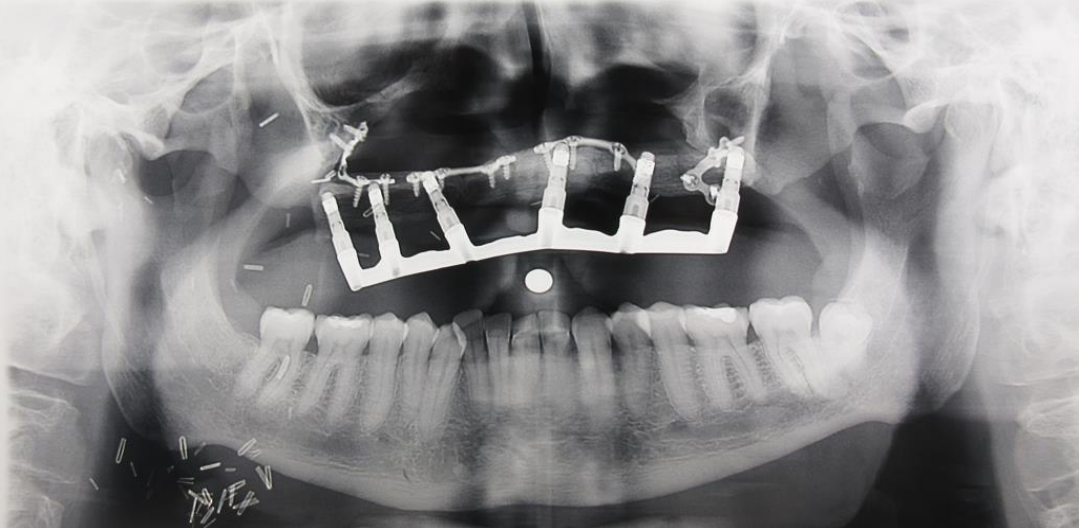
Figure 3. Final implant-supported prosthesis rehabilitation on a free fibula flap reconstruction. (25 February 2020).